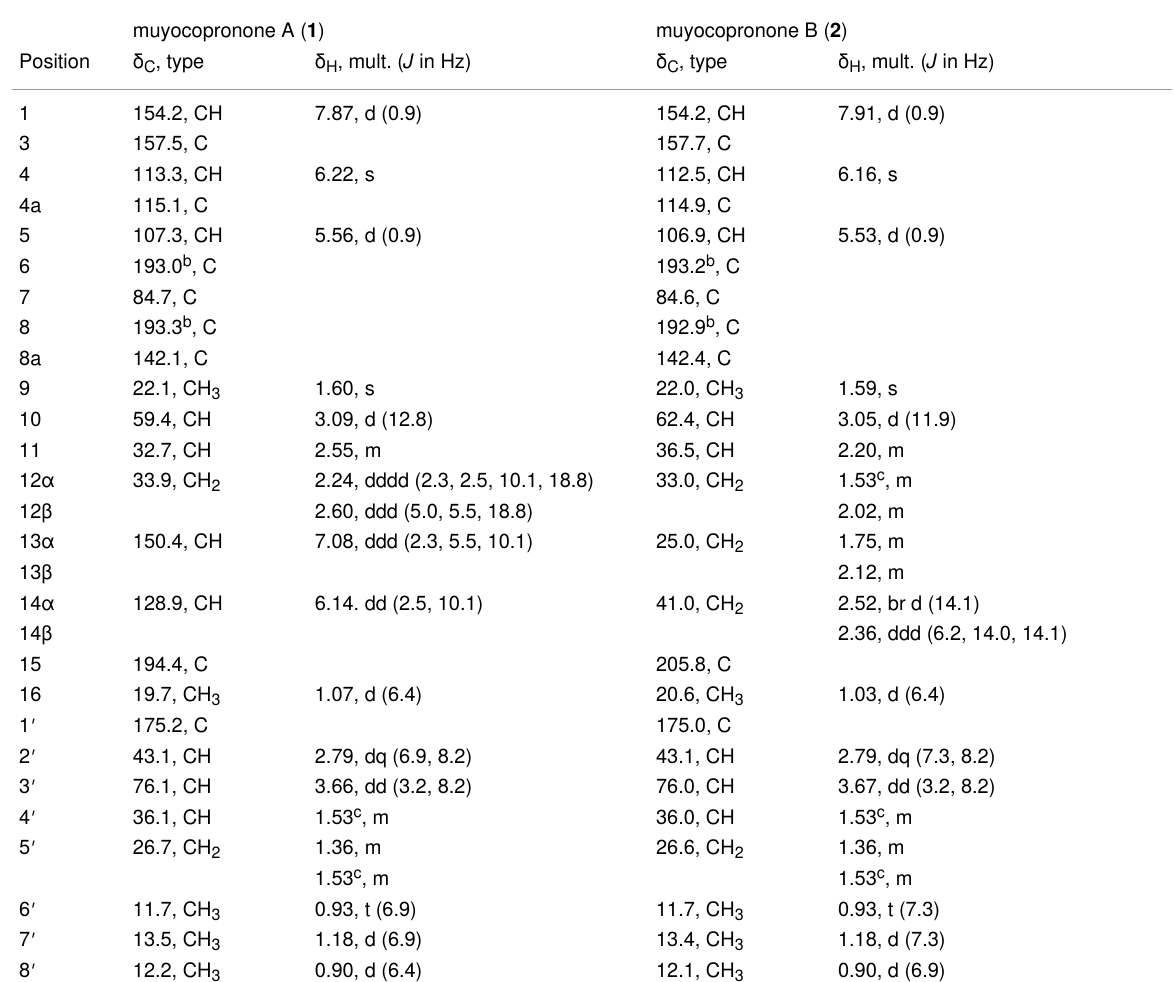
Table 1: 1 H and 13 C NMR spectroscopic data for 1 and 2 a .